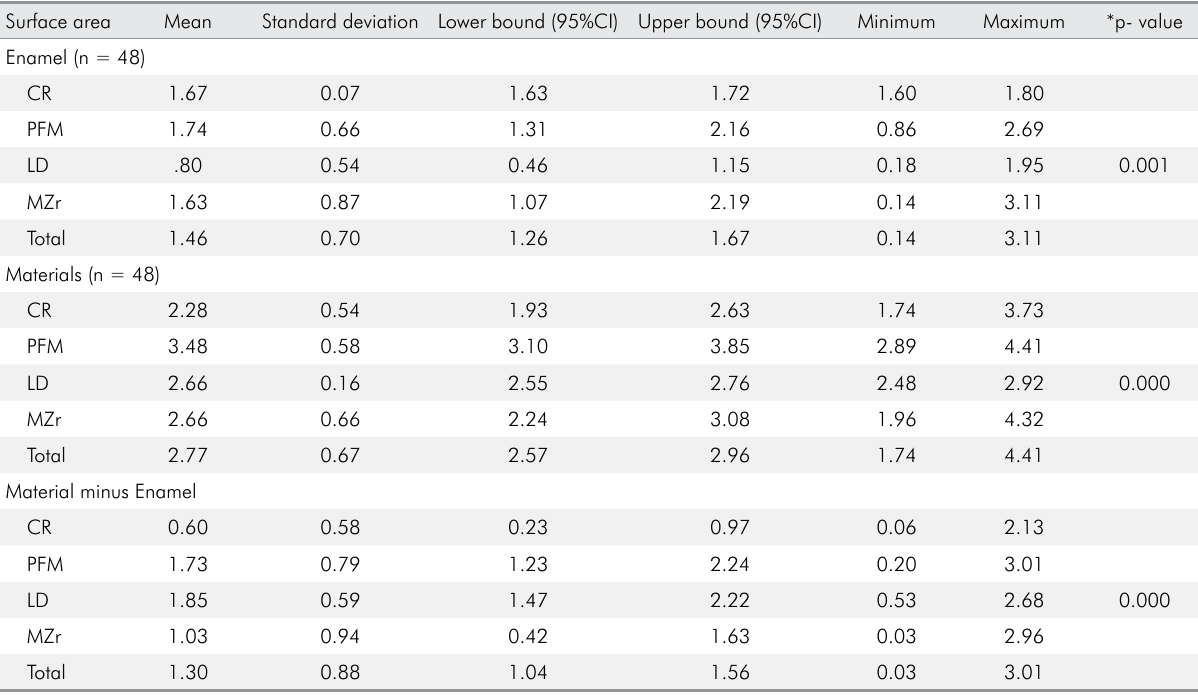
Table 2. Descriptive statistics and ANOVA results of the wear surface areas of tested materials and antagonist enamel specimens. Surface area